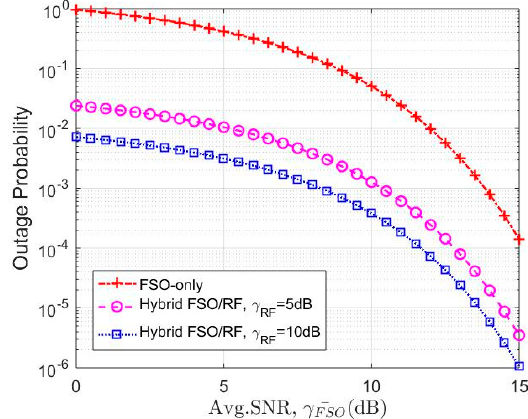
Figure 3. Probability as a function of average SNR of FSO link.